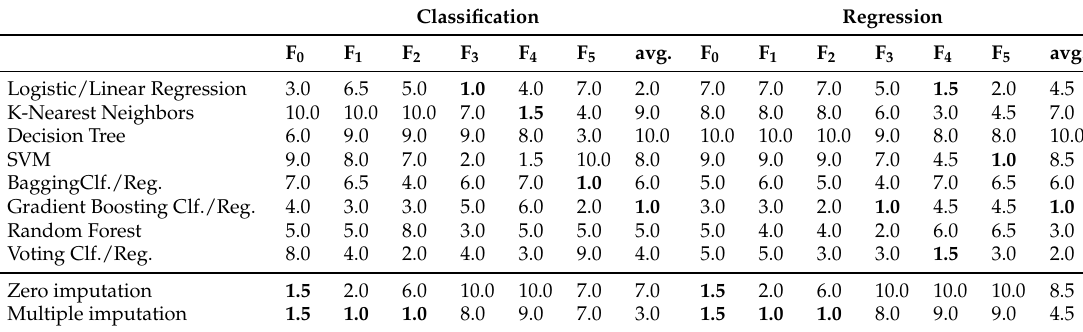
Table 8. Rankings of classification and regression models for different feature sets for